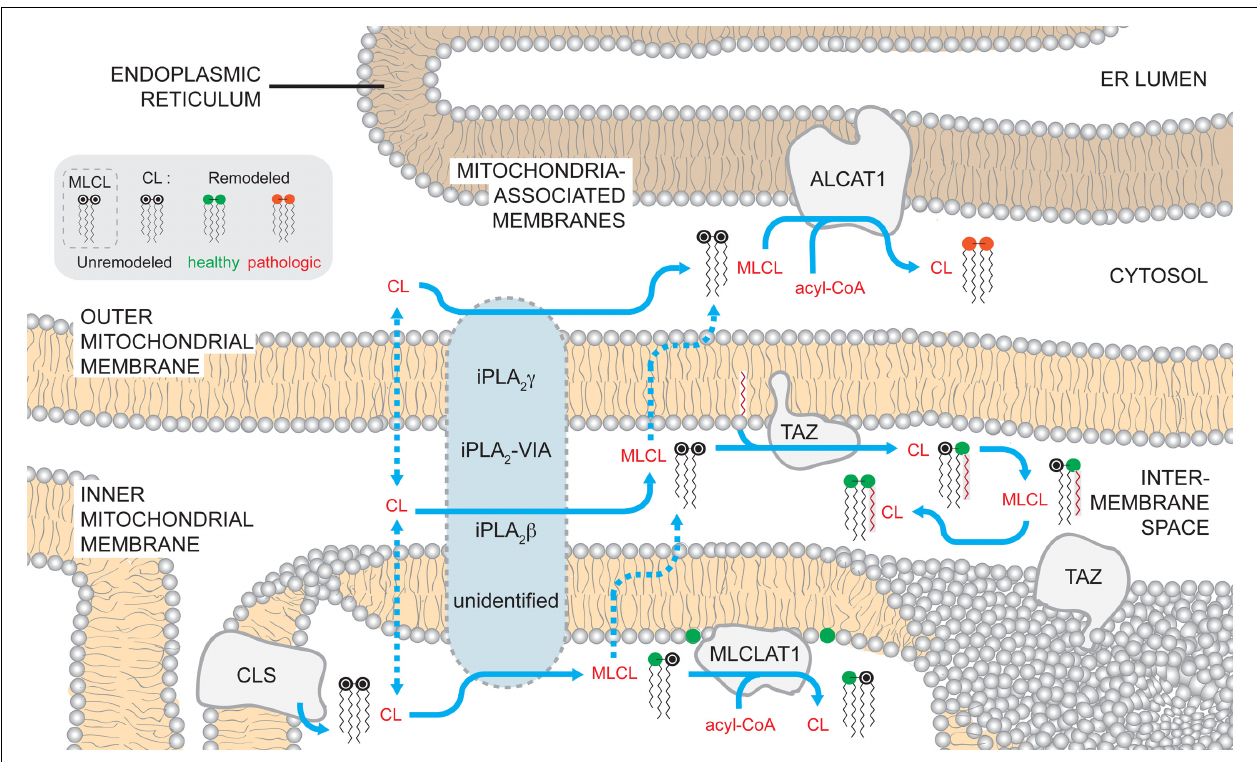
FIGURE 2 | Mammalian cardiolipin remodeling. CL that is synthesized by CLS on the matrix-facing leaflet of the IMM can by remodeled by three different pathways. While no single enzyme has been demonstrated to be required to initiate CL remodeling in mammals, several phospholipases of the iPLA 2 family have been demonstrated to have a role in the process. Additionally, the submitochondrial localization of the phospholipases and the mechanisms by which CL gains access to these enzymes are unknown. After a fatty acyl chain is hydrolyzed from CL, generating MLCL, MLCL can be acylated back to CL by acyltransferases or transacylases. MLCLAT1 on the matrix-leaflet of the IMM, TAZ on the IMS-facing leaflets of the OMM and IMM, and ALCAT1 on the ER MAM